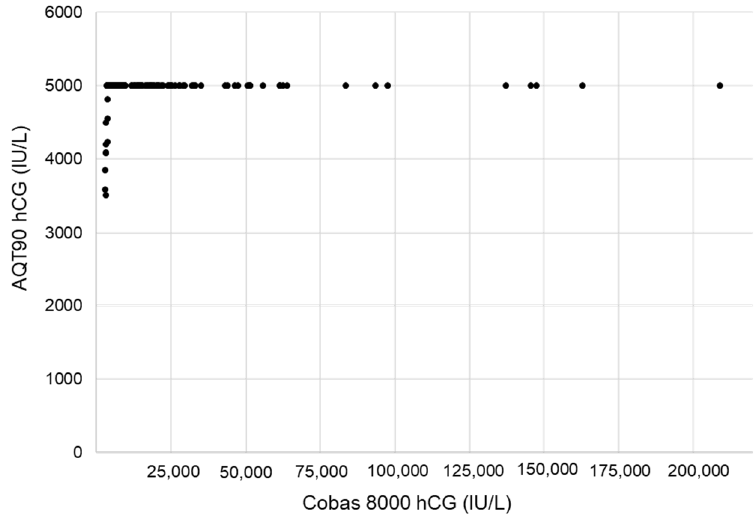
Figure 5. Evaluation of the high-dose hook effect by comparing the hCG results obtained on e602/Cobas 8000 (plasma) and those obtained on AQT90 (whole blood) in the emergency department for samples greater than 3000 IU/L using the Elecsys hCG + β tests ( n = 180).